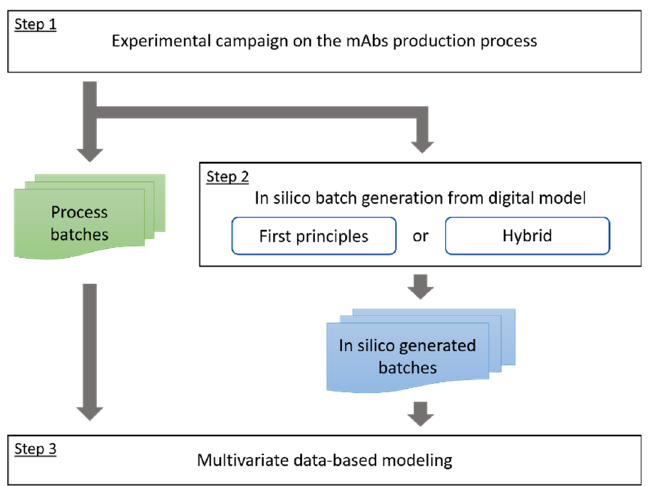
Figure 1. Methodological procedure for in silico data augmentation from digital models.